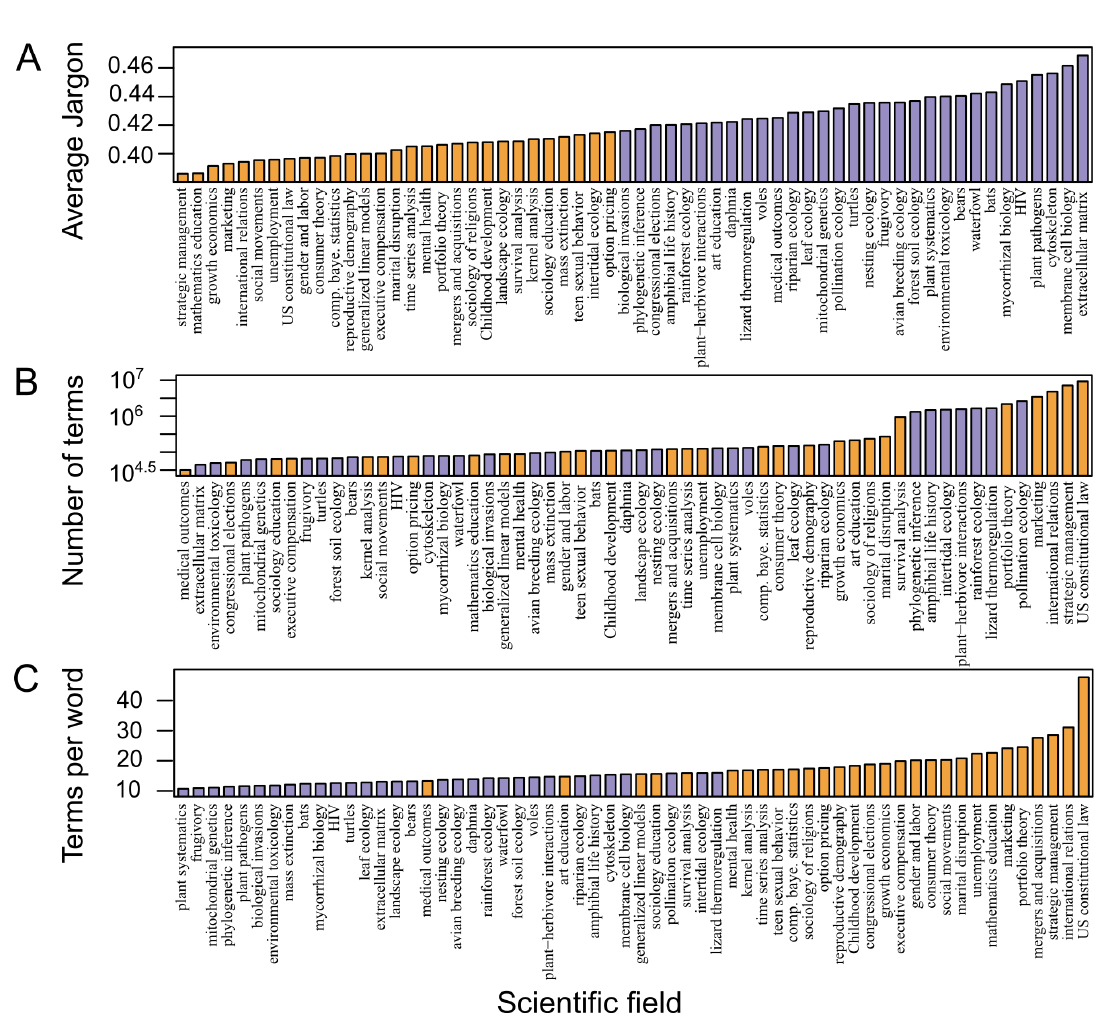
C ij /N across fields. Note that biological sciences are Figure 1: (A) Average cultural hole C i = (cid:80) j surrounded by systematically larger cultural holes than social sciences. (B) Total number of phrases (distinct three word combinations/trigrams) in each codebook. Note that there is no pattern at the domain level, that is, biological sciences (blue) and behavioral/social sciences (orange) do not vary systematically in the number of phrases. (C) Number of phrases per distinct word in each field. Note the systematic difference between biological sciences (blue) and behavioral sciences (orange). This pattern suggests that social science fields use fewer words in more combinations, whereas word combination in the biological sciences is more